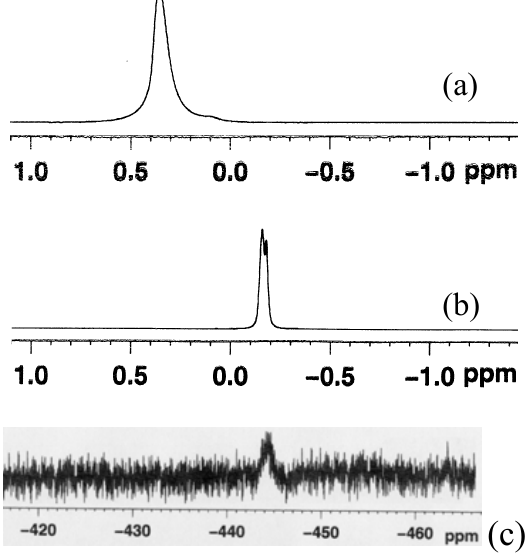
Fig. 2 7 Li NMR spectra at 298 K of: a) Li 2 Se 2 ; b) Li 2 Se (both in THF). c) 77 Se spectrum of Li 2 Se 2 at 298 K in mixture of solvents d-benzene and terahydrofuran (0.6:0.2